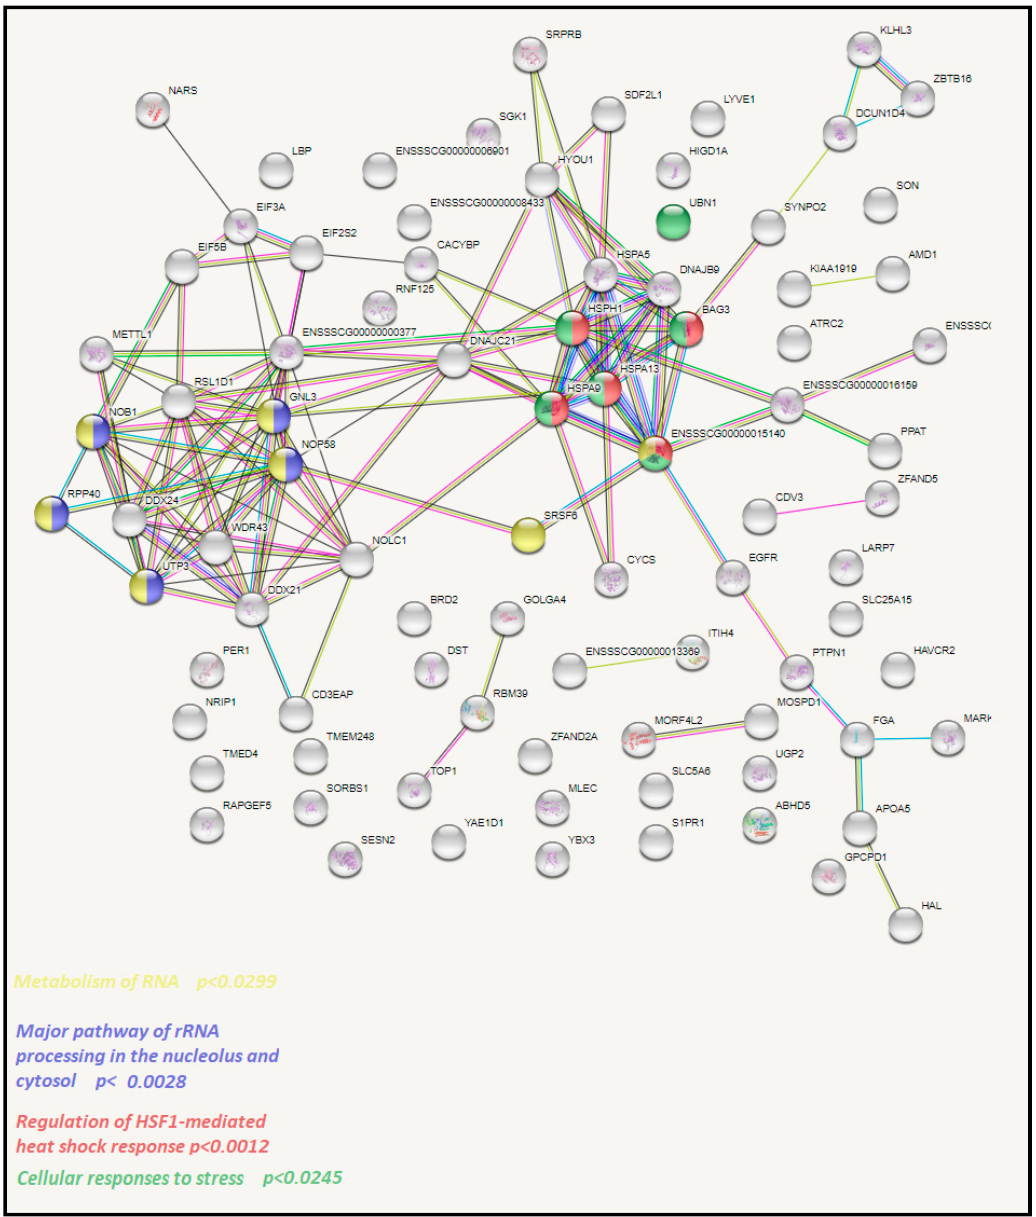
Figure 4. The network of DEGs upregulated in the beef tallow group when compared to the rapeseed oil group according to STRING software analysis.